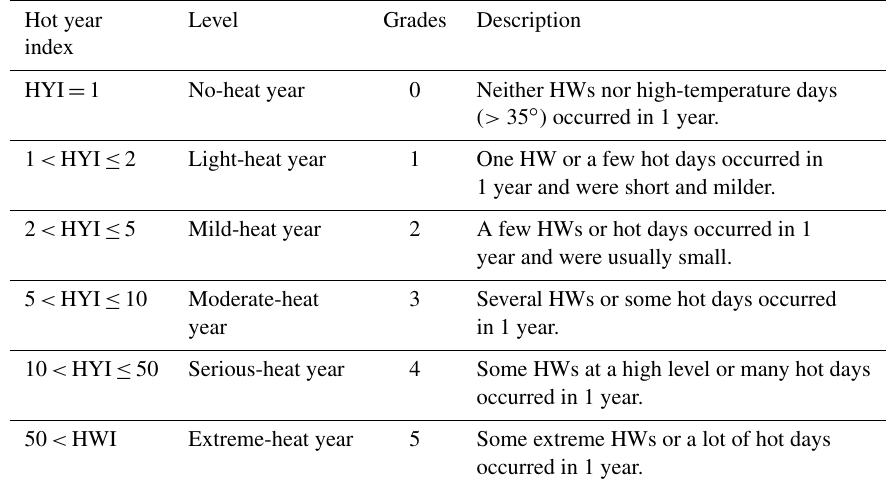
Table 2. The classification of hot years by the values of HYI. Hot year Level Grades Description index HYI = 1 No-heat year 0 Neither HWs nor high-temperature days ( > 35 ◦ ) occurred in 1 year. 1 < HYI ≤ 2 Light-heat year 1 One HW or a few hot days occurred in 1 year and were short and milder. 2 < HYI ≤ 5 Mild-heat year 2 A few HWs or hot days occurred in 1 year and were usually small. 5 < HYI ≤ 10 Moderate-heat 3 Several HWs or some hot days occurred year in 1 year. 10 < HYI ≤ 50 Serious-heat year 4 Some HWs at a high level or many hot days occurred in 1 year. 50 < HWI Extreme-heat year 5 Some extreme HWs or a lot of hot days occurred in 1